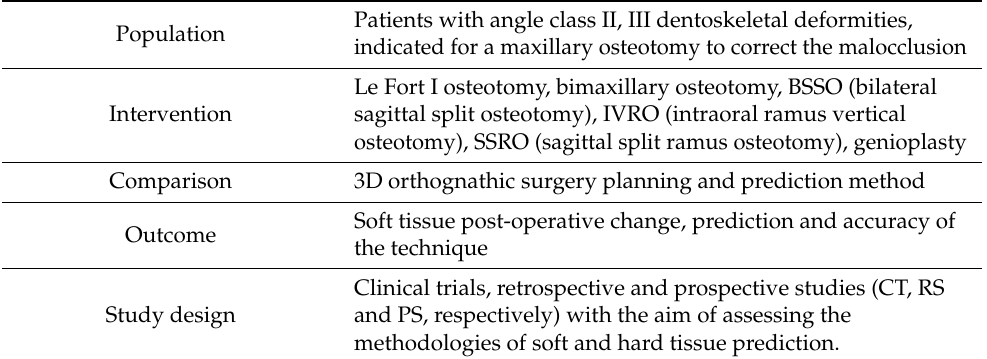
Table 1. PICOS (Population Intervention Control Outcome Study) criteria for the systematic review.